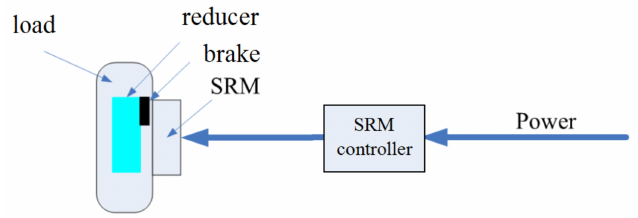
Figure 3. The wheel electric drive system based on an SRM.